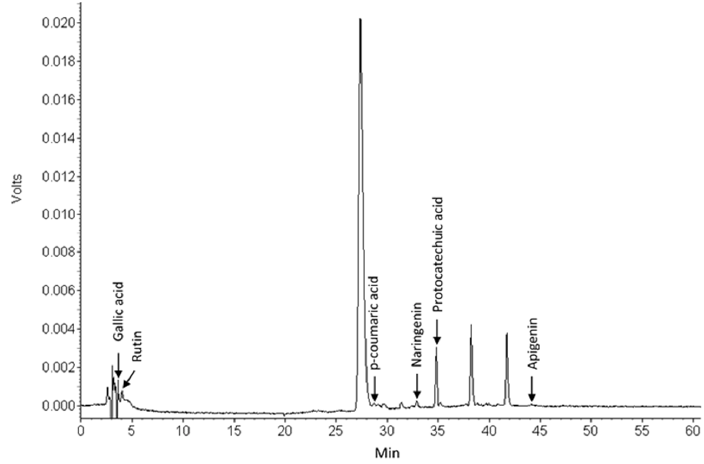
Figure 2. HPLC chromatogram of the methanolic extract from carrot peel.